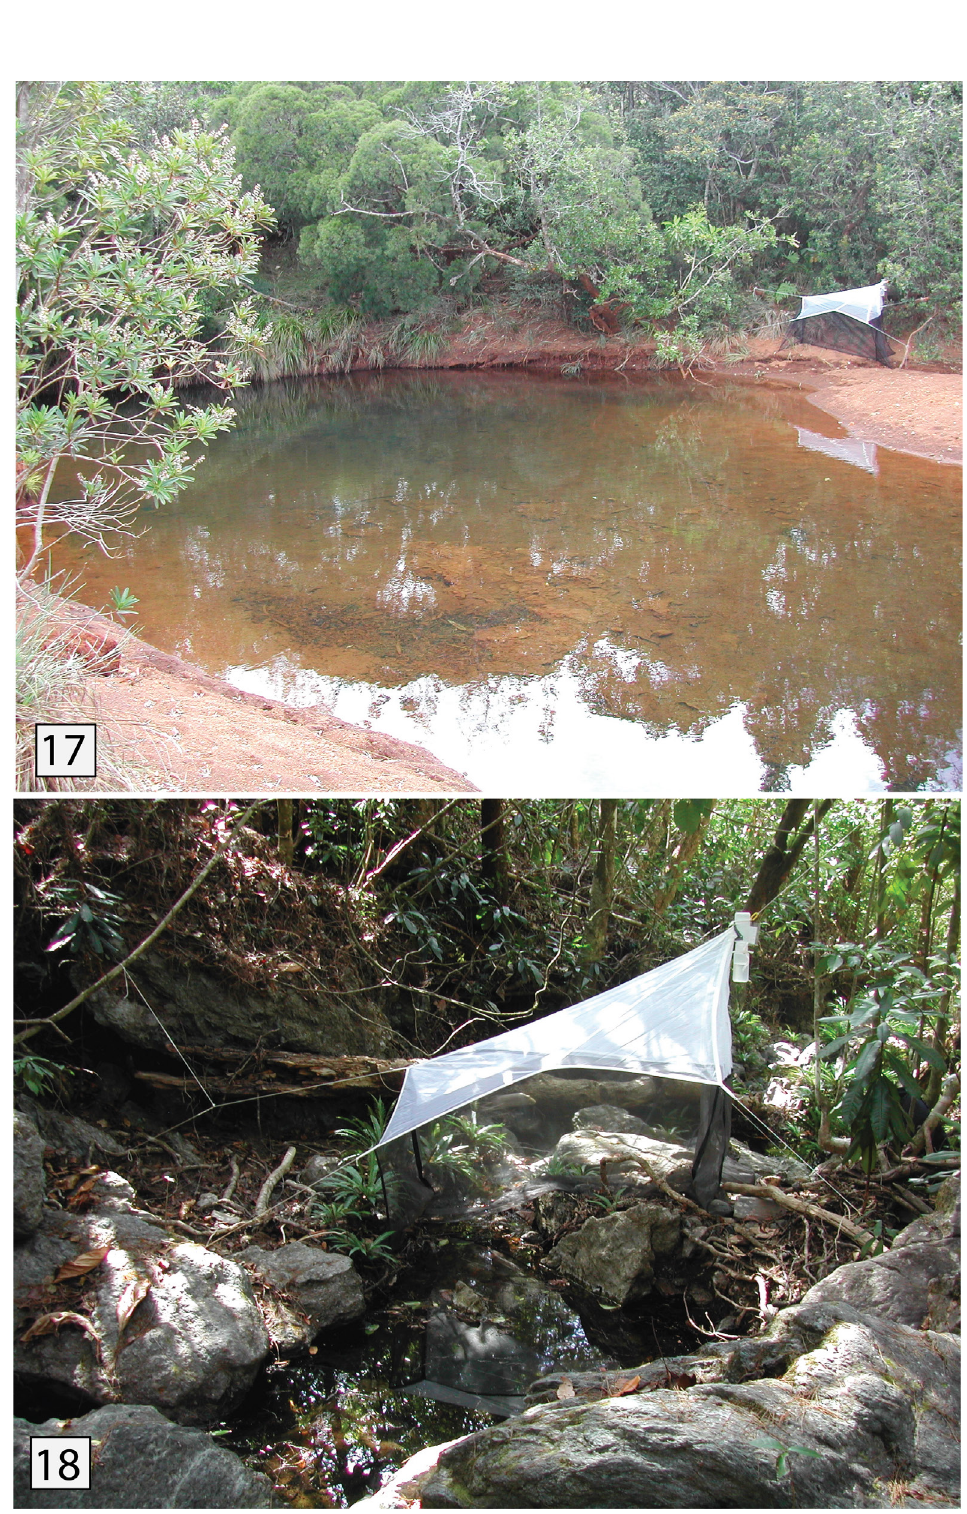
Figs 17–18. Type localities with Malaise traps. 17 . Type locality of Caledomina dorsospina sp. nov. 18 . Type locality of Caledomina kohensis sp.